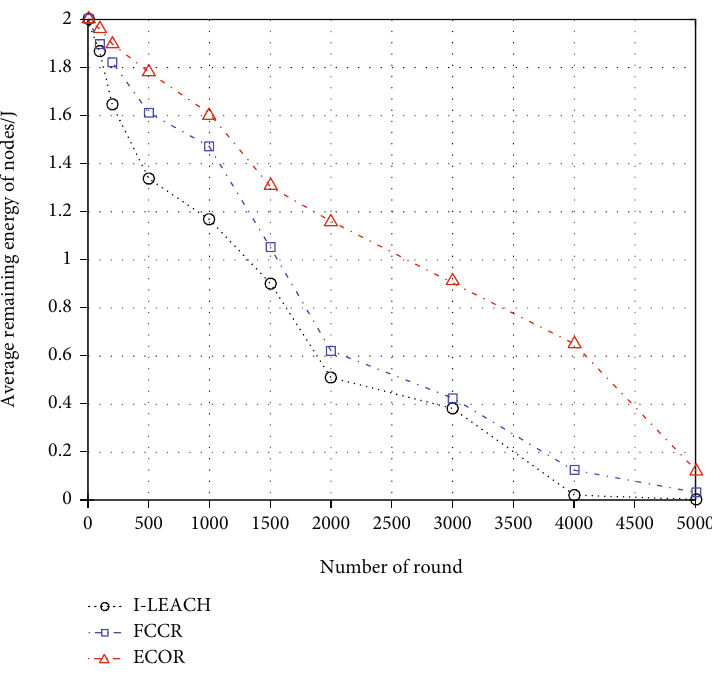
Figure 13: Performance analysis in terms of average remaining energy.